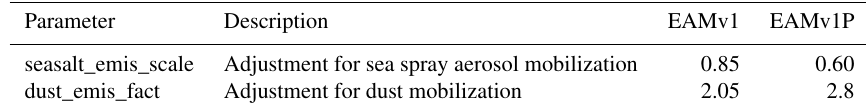
Table 4. Description of scale factors of emissions and their values in EAMv1 and EAMv1P.